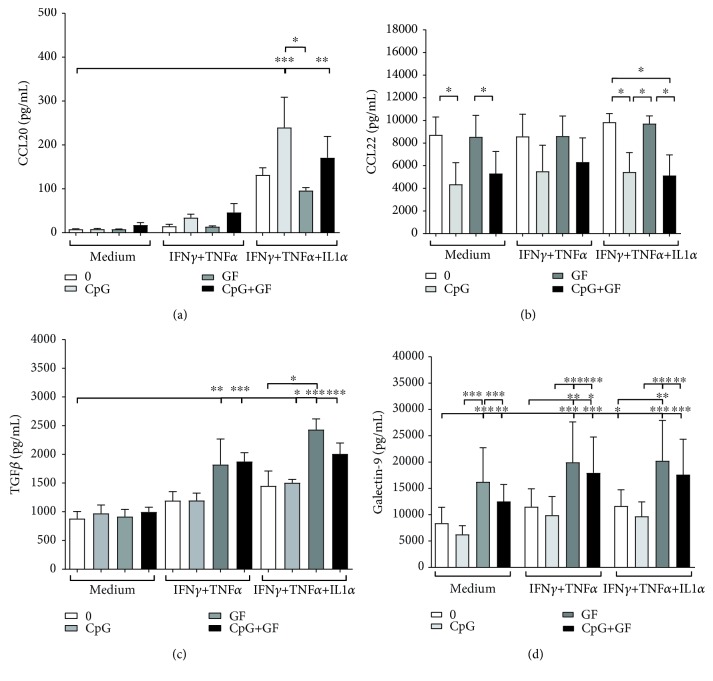
scGOS/lcFOS±CpG-ODN exposure of IFNγ/TNFα/IL1α-activated IEC increases CCL20, TGFβ, and galectin-9 while decreasing CCL22 in IEC-DC cocultures. After 48 hours of coculture of HT29 cells and imDC, (a) CCL20, (b) CCL22, and (d) galectin-9 were measured in the supernatants. After 24 hours of coculture, (c) TGFβ was measured in the supernatant. Legend: exposure to medium (white bars; 0), CpG-ODN (light grey bars; CpG), scGOS/lcFOS (dark grey bars; GF), or CpG-ODN+scGOS/lcFOS (black bars; CpG+GF); N = 3. One-way ANOVA on normalized data, post hoc test Tukey; ∗
p < 0.05; ∗∗
p < 0.01; and ∗∗∗
p < 0.001.